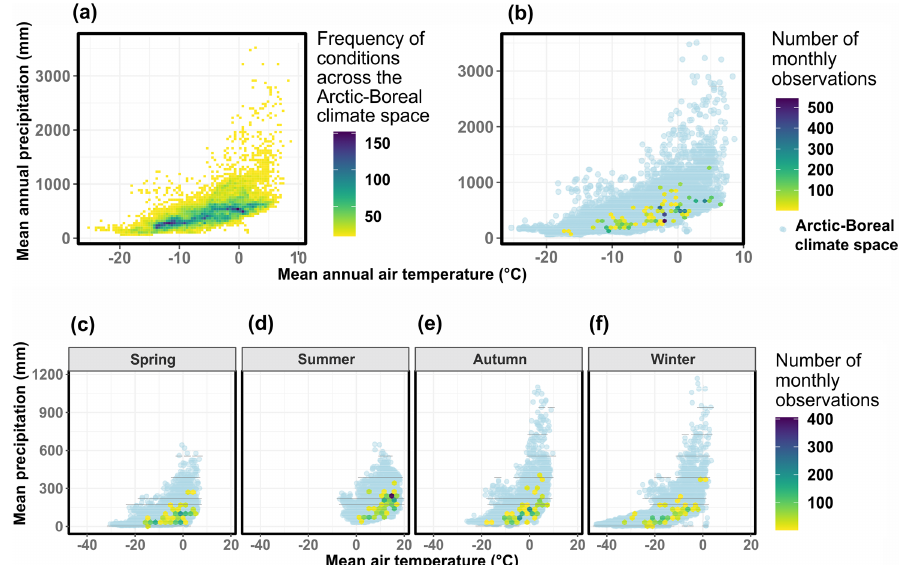
Figure 5. Mean annual air temperature and precipitation conditions across the Arctic–boreal zone (a) , the entire ABCflux (b) , and the air temperature and precipitation conditions across the different climatological seasons included in ABCflux (c–f) . Arctic–boreal climate space was defined based on a random sample of 20000 pixels across the domain.